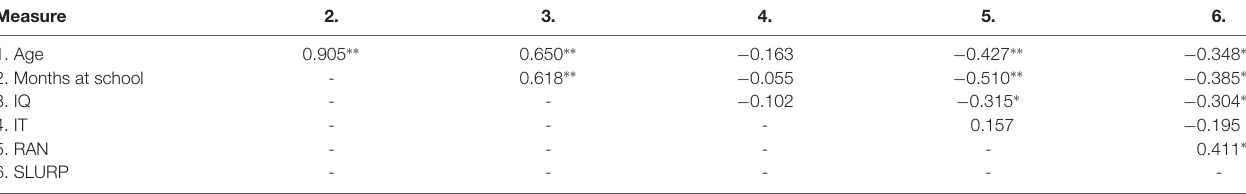
TABLE 2 | Correlation (Pearson’s r) between age, months at school, nonverbal intelligence, visual processing, visual-verbal processing, and visuomotor skills. Measure